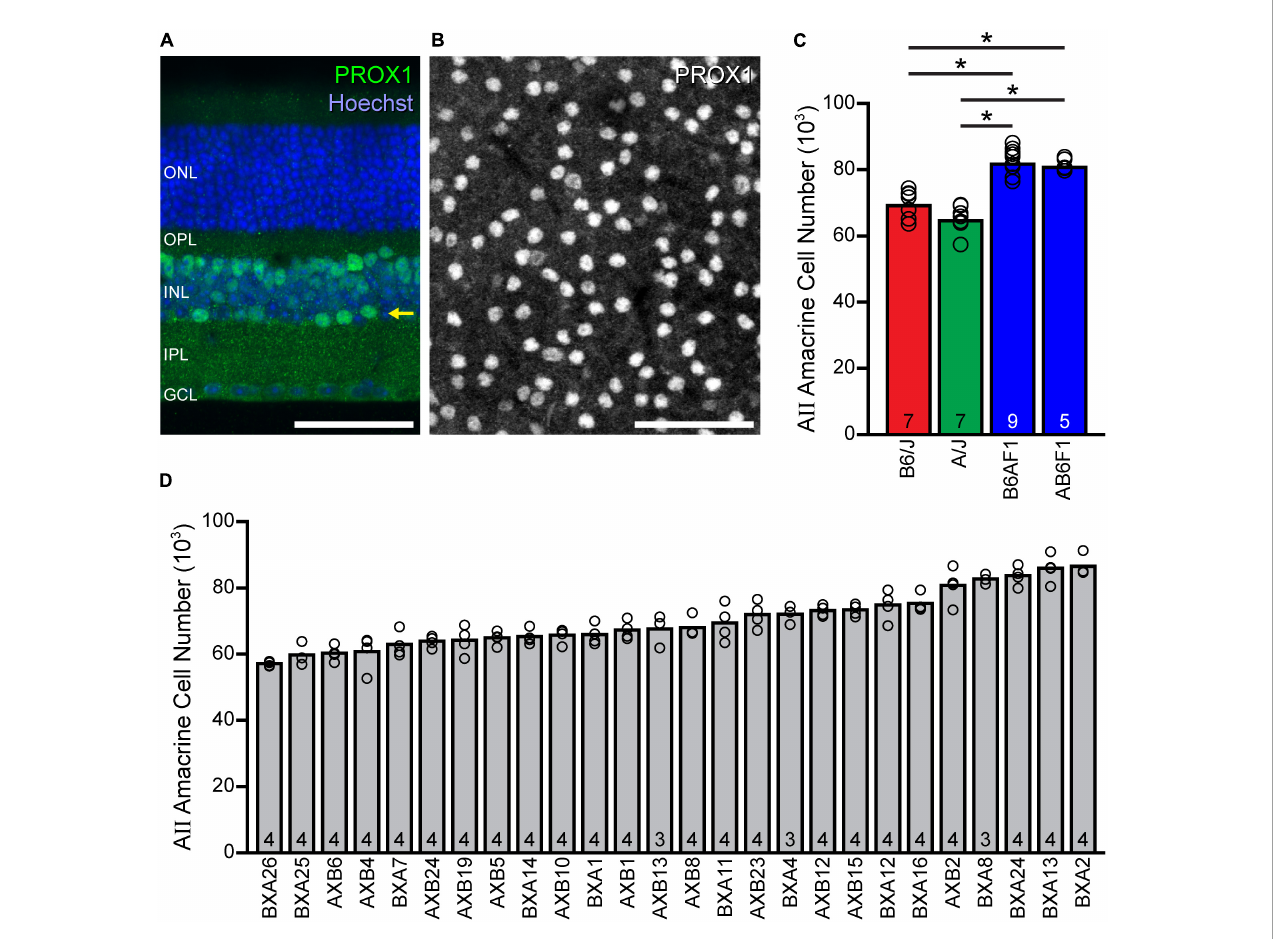
FIGURE1 AII amacrine cell number shows considerable variation across mouse strains. (A) Cross-section showing the stratification of AII somata (arrow), immunolabeled using PROX1 antibodies, at the inner nuclear layer (INL)/inner plexiform layer (IPL) boundary. (B) Wholemount preparation showing the somal distribution of AII cells labeled for PROX1 within this stratum. Calibration bars = 50 µ m. (C) Counts of PROX1-labeled AII cells in wholemount preparations reveal slight differences in total cell number between the parental B6/J and A/J strains of mice, as well as between their two reciprocal F1 offspring (B6AF1 and AB6F1), yet there exists a large difference between each parental strain and each F1 strain. (D) The total number of AII amacrine cells varies across the 26 recombinant inbred strains of the AXB/BXA strain-set, by nearly 30,000 cells. Note that the within-strain variation is meager when compared to the across-strain variation, and that the latter variation is gradual, indicative of a polygenic trait. n = the number of retinas sampled (from the supplementary appendix in Keeley et al.,